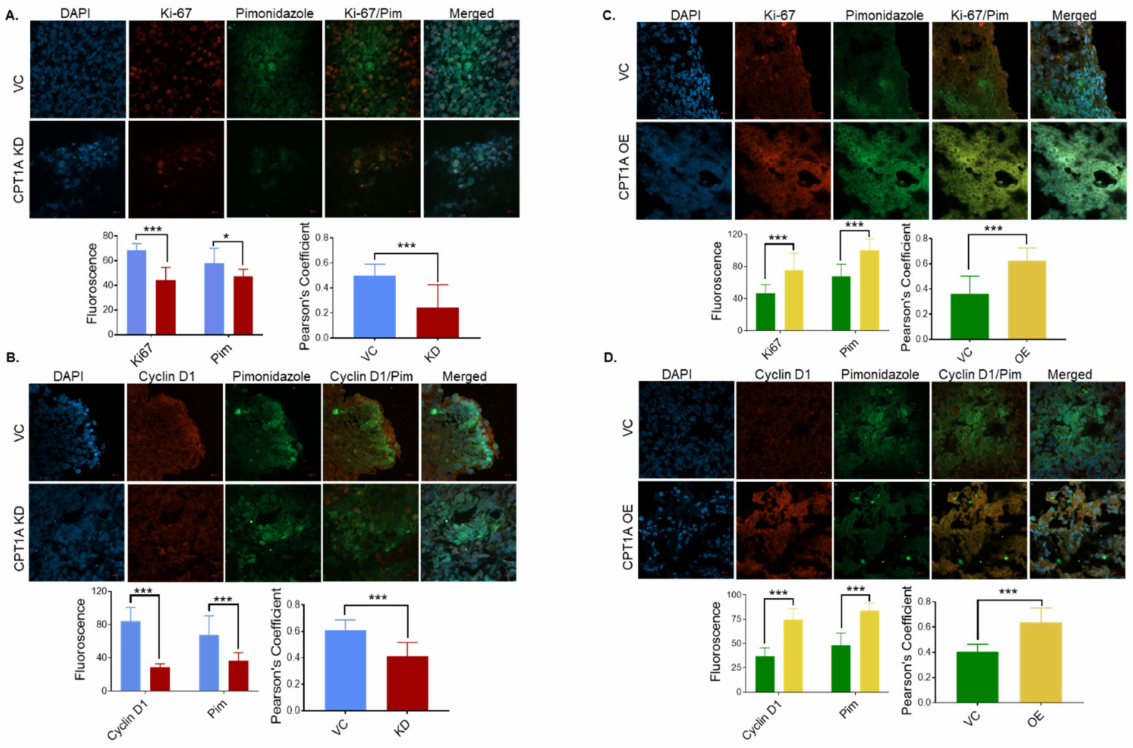
Figure 4. CPT1A regulates cell proliferation in hypoxic regions of 22Rv1 tumors. Mice were injected pimonidazole (120 mg/kg, IP) before sacrifice as described in the Methods, and subsequently tumor tissues were placed in OCT. Next, OCT sections were stained with FITC conjugated antibody anti-pimonidazole (green) and proliferation biomarkers (Ki67 and cyclin D1) using rabbit anti-Ki-67 and rabbit anti-cyclin D1 primary antibodies. Both Ki67 and cyclin D1 were stained using Alexa Fluor 555-tagged secondary antibody (red) and slides were analyzed by confocal microscopy. ( A – D ) Representative photomicrographs (at 40 × ) are shown for vector control (VC) versus CPT1A knockdown (KD) for Ki67 and cyclin D1 ( A , B ). Representative photomicrographs (at 40x) are shown for vector control (VC) versus CPT1A overexpressing (OE) for Ki67 and cyclin D1 ( C , D ). Images were quantified to measure the relative expression of Ki67, cyclin D1, and pimonidazole. The fluorescent intensity of the images was measured using Image J by analyzing 10 images for each condition and 5 measurements for each image (left graph in each panel). Colocalization of Ki67/cyclin D1 and pimonidazole was measured as Pearson’s correlation by ImagJ (version 1.53e) Colol2 plugin (right graph in each panel). Graphs were plotted with GraphPad Prism. Note: * < p = 0.05, *** < p = 0.001. Scale bar = 20 µ